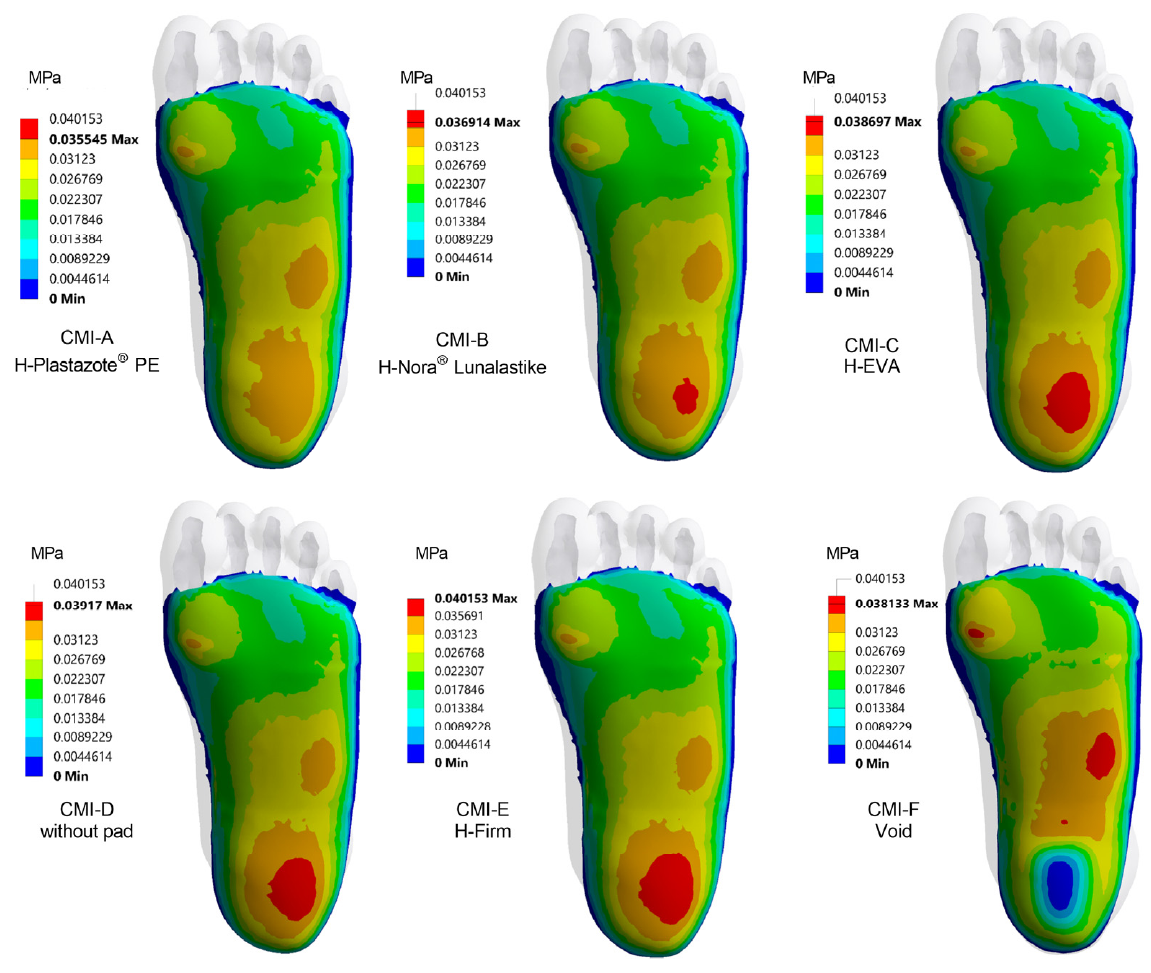
Figure 4. The plantar pressure obtained from FEA models using heel (H) pad made from various materials from soft to hard (CMI-A to CMI-E), without heel pad (CMI-D), and with void (CMI-F). The heel–forefoot pad fabricated from a softer material provided a better distribution of plantar pressure at the medial forefoot and hindfoot compared with stiffer materials and the insole without a pad (Figure 5). In contrast with stiffer materials, the soft material heel–forefoot pad reduced the peak contact pressure at the hindfoot. The maximum peak contact pressure was reduced by 20.84% with the softest heel pad (CMI-G) compared with the insole without a heel pad (CMI-J). Moreover, the reduction in the peak contact pressure was 23.24% with CMI-G compared with the firm heel–forefoot pad (CMI-K). On the other hand, the peak contact pressure using the heel–forefoot void (CMI-L) was increased by 34.80% and shifted from the hindfoot to the medial midfoot compared with CMI-G. The regions of high contact pressure under the 1st to 5th metatarsal heads were shifted to a distal part of the metatarsal heads with